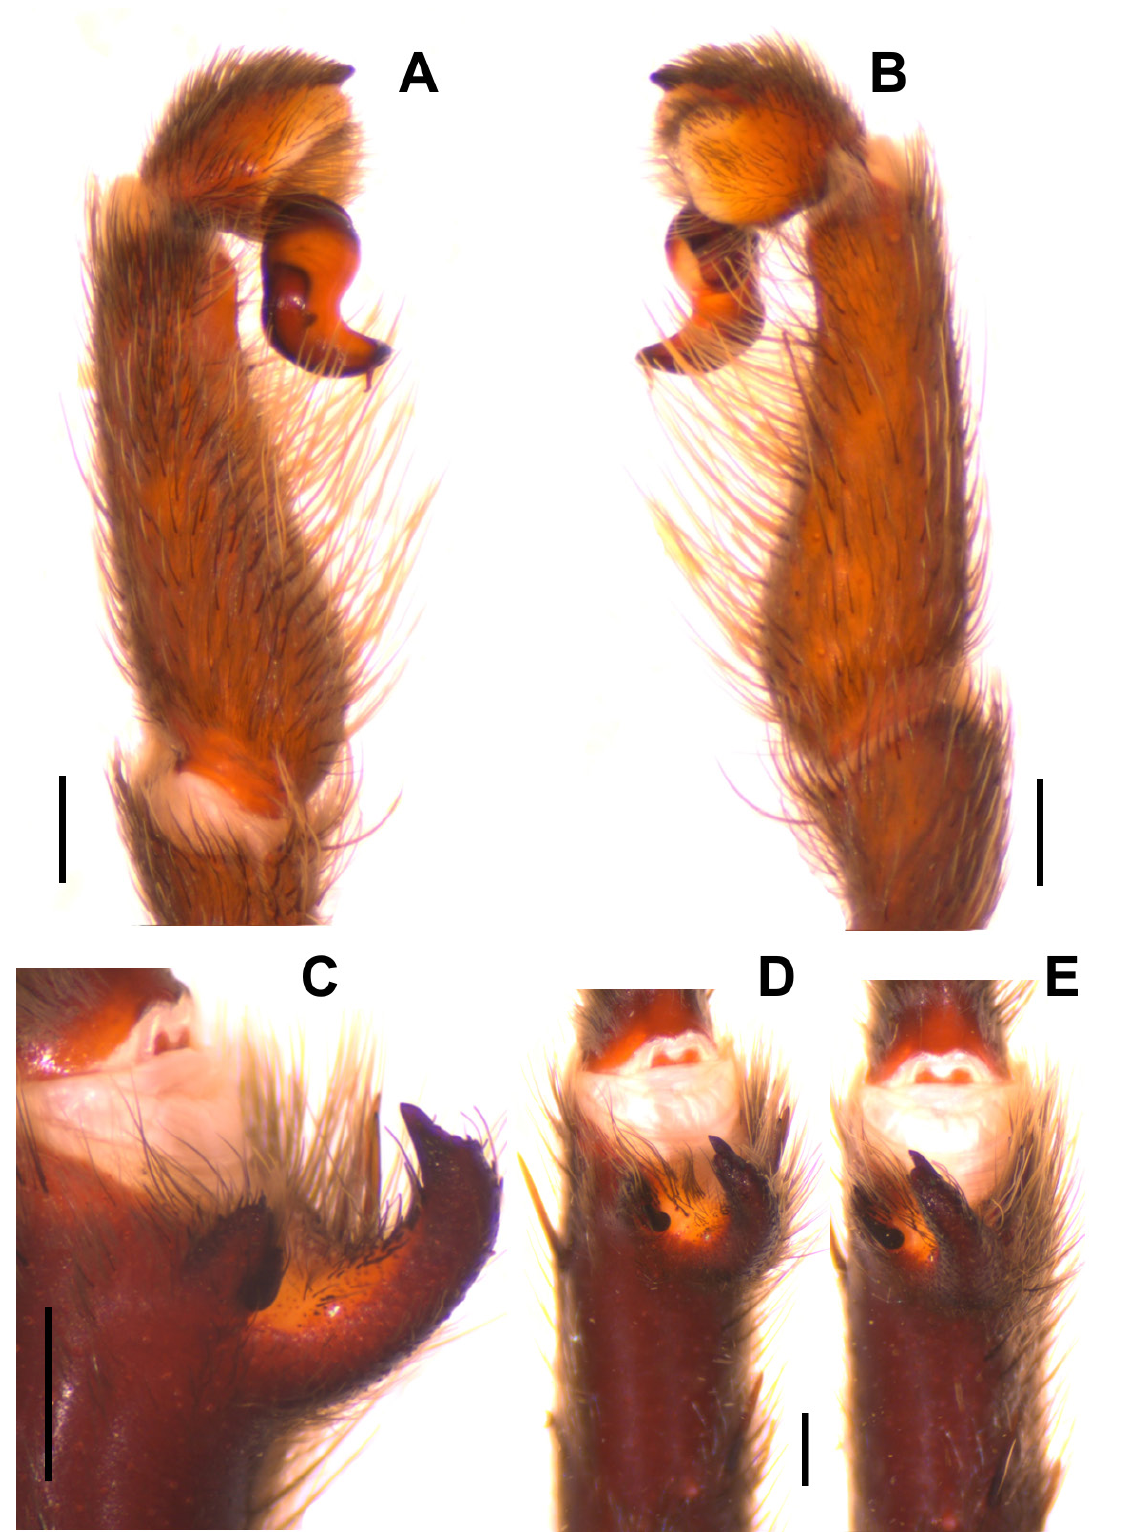
Fig. 9. Bistriopelma kiwicha sp. nov., holotype, ♂ (MUBI 12). A – B . Cymbium, tibia and patella. A . Prolateral view. B . Retrolateral view. – C – E .Tibial apophysis. D . Retrolateral view (detail of branches). D . Retrolateral view. E . Ventral view. Scale bars = 1